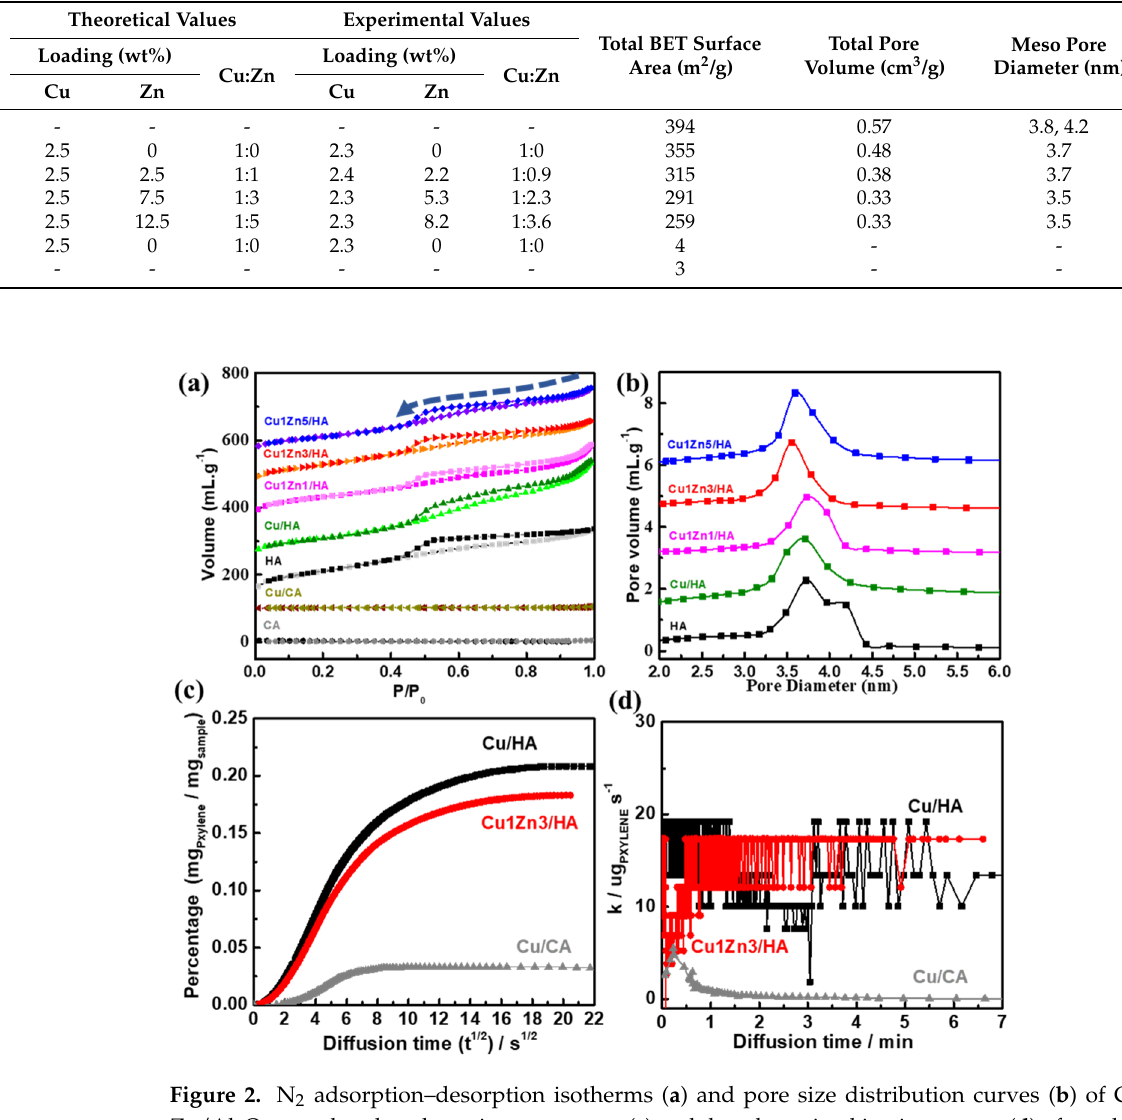
Table 1. Metal loadings and textural properties of as-prepared Cu–Zn/alumina catalysts.